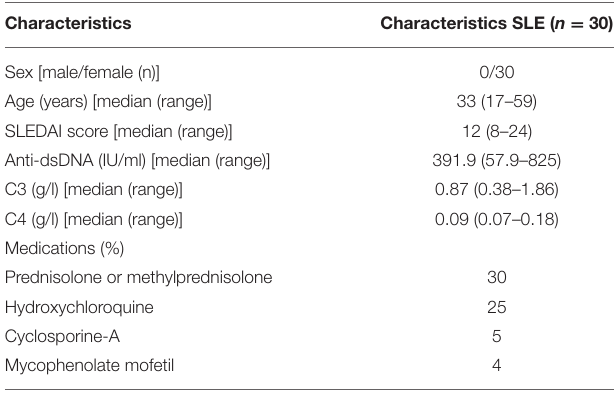
TABLE 1 | Clinical and laboratory characteristics of the patients with SLE in the study.